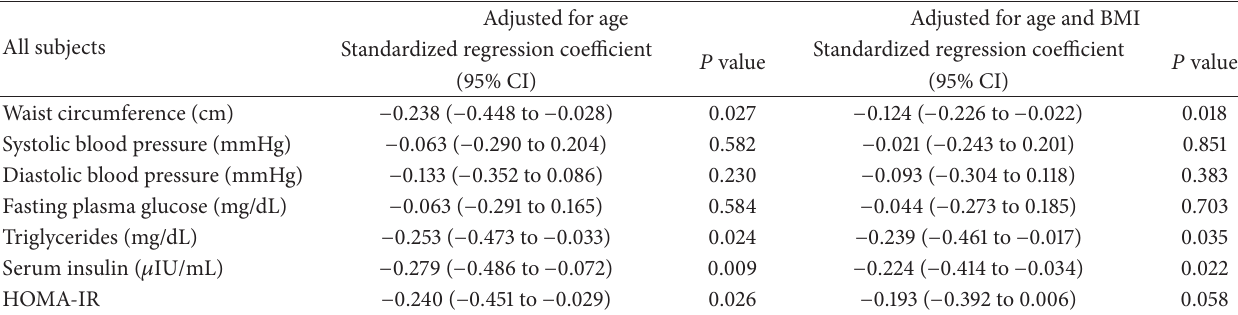
Table 2: Standardized regression coefficients of physical activity levels with metabolic risk factors in 80 adults with prediabetes or type 2